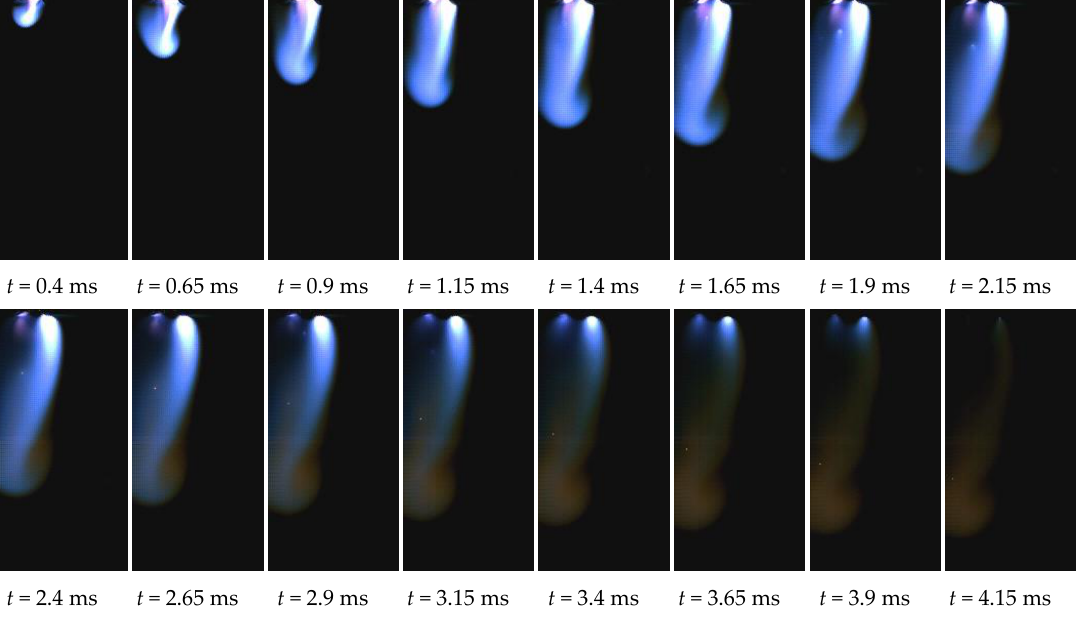
Figure 5. Plasma jet flow sequence during discharge.